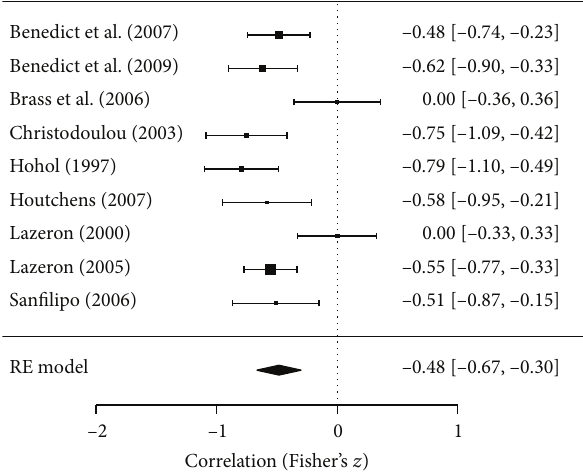
Figure 2: Correlation between T2LV and SDMT processing speed in patients with mixed MS subtypes.